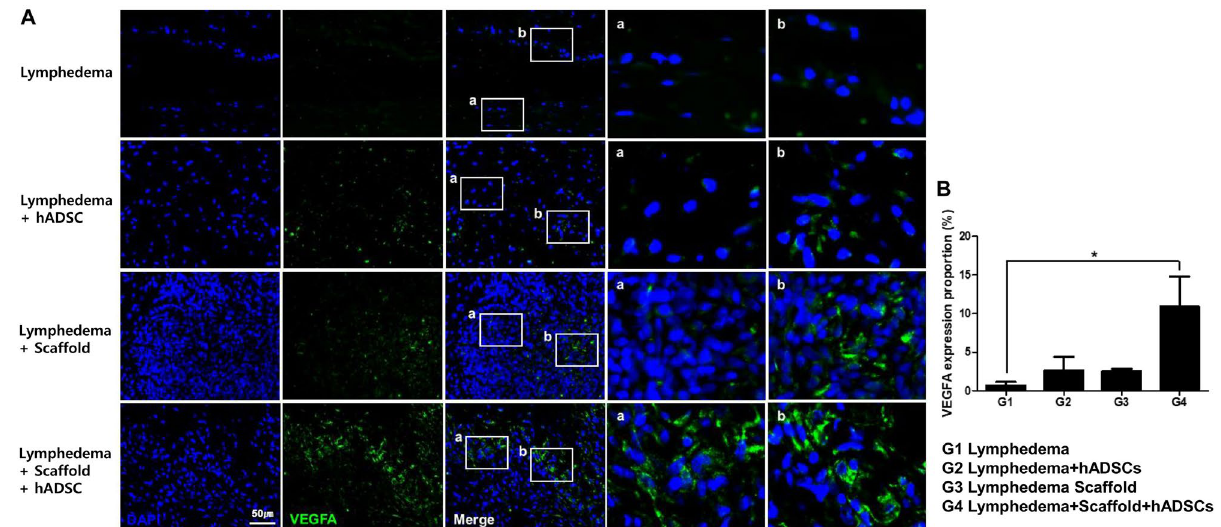
Figure 4. VEGFA expression was assessed by immunofluorescence staining. ( A ) VEGFA was not expressed in lymphedema group. The expression of VEGFA hardly observed in ADSCs injection and Decell LN-scaffold groups. In the Recell LN-scaffold group, VEGFA was significantly expressed in many cells. ( B ) Bar graphs showing that rat in the Recell LN-scaffold group had the greatest number of VEGF-positive cells (* P < 0.05). VEGFA, vascular endothelial growth factor A.